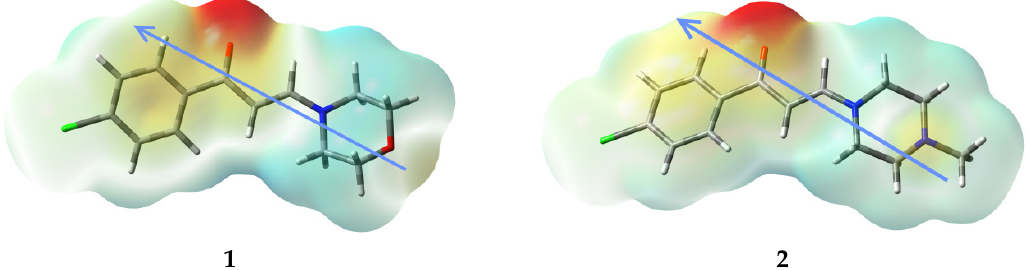
Figure 10. The MEP map and the dipole moment vector of the studied compounds 1 , and 2 . The color index from turquoise to yellow to red indicated the more negative electron density.